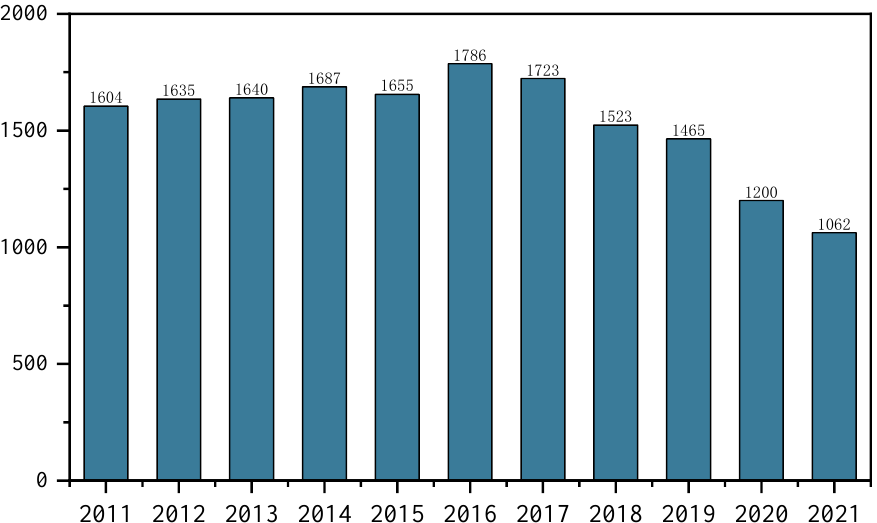
Figure 4. Number of births in China, 2011 – 2021 (10,000). Data source: China National Economic and Social Development Statistical Bulletin, 2011 – 2021.